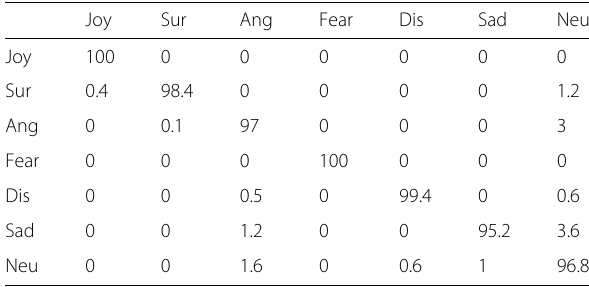
Table 6 Confusion matrix (%) of leave-one-out testing method for 7-class emotion in CK+ dataset using Improved GLTP